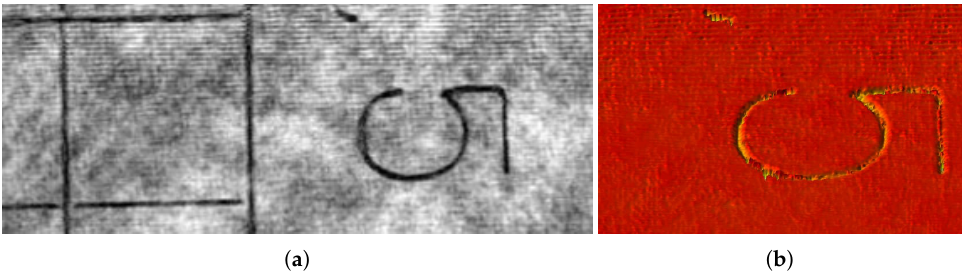
Figure 11. Object reconstruction ( a ) The amplitude image | a | 2 ; ( b ) Phase image ϕ = atan [ Imag ( a ) / Real ( a )]